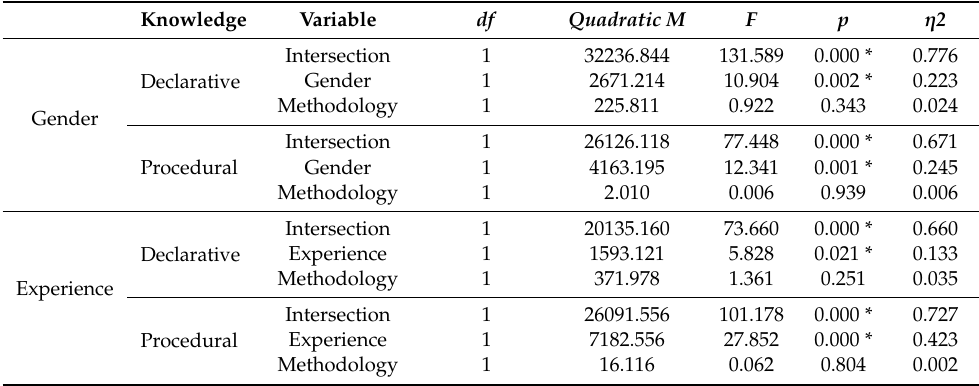
Table 6. E ff ect of the methodologies on gender and experience in